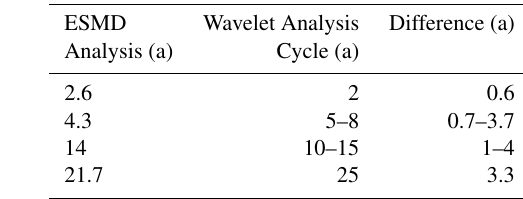
Table 2. Comparison of the cycle result by ESMD and Wavelet